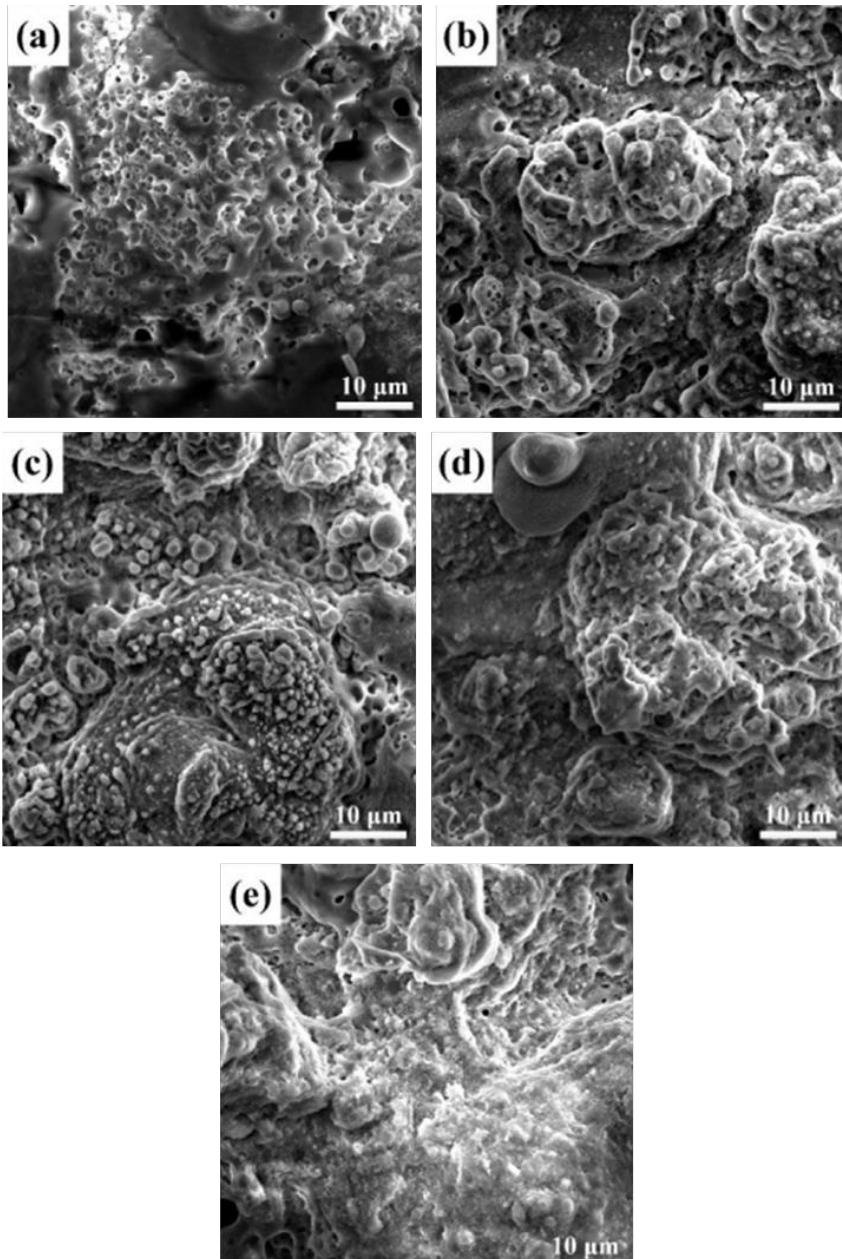
Figure 1. Surface SEM images of ( a ) unsealed MAO film and ( b ) MAO films sealed by different concentrations of SiO 2 nanoparticles: 2.5 g/L, ( c ) 5 g/L ( d ) 7.5 g/L and ( e ) 10 g/L.